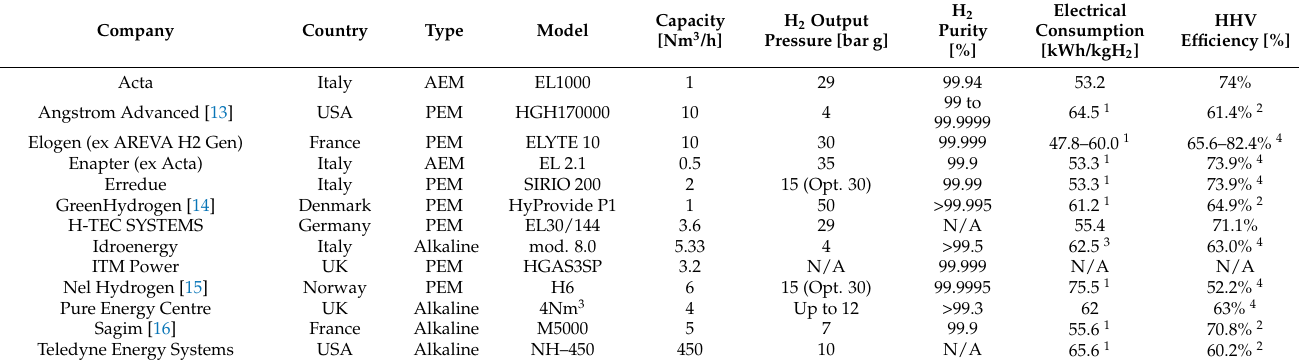
1 Data obtained by conversion from kWh/Nm 3 to kWh/kg using a hydrogen density of 0.09 kg/Nm 3 ; 2 Data obtained by conversion from an efficiency given on an LHV basis; 3 Data calculated by authors from production rates and maximum electrical consumption stated in data sheets; 4 Data calculated by authors from the electrical